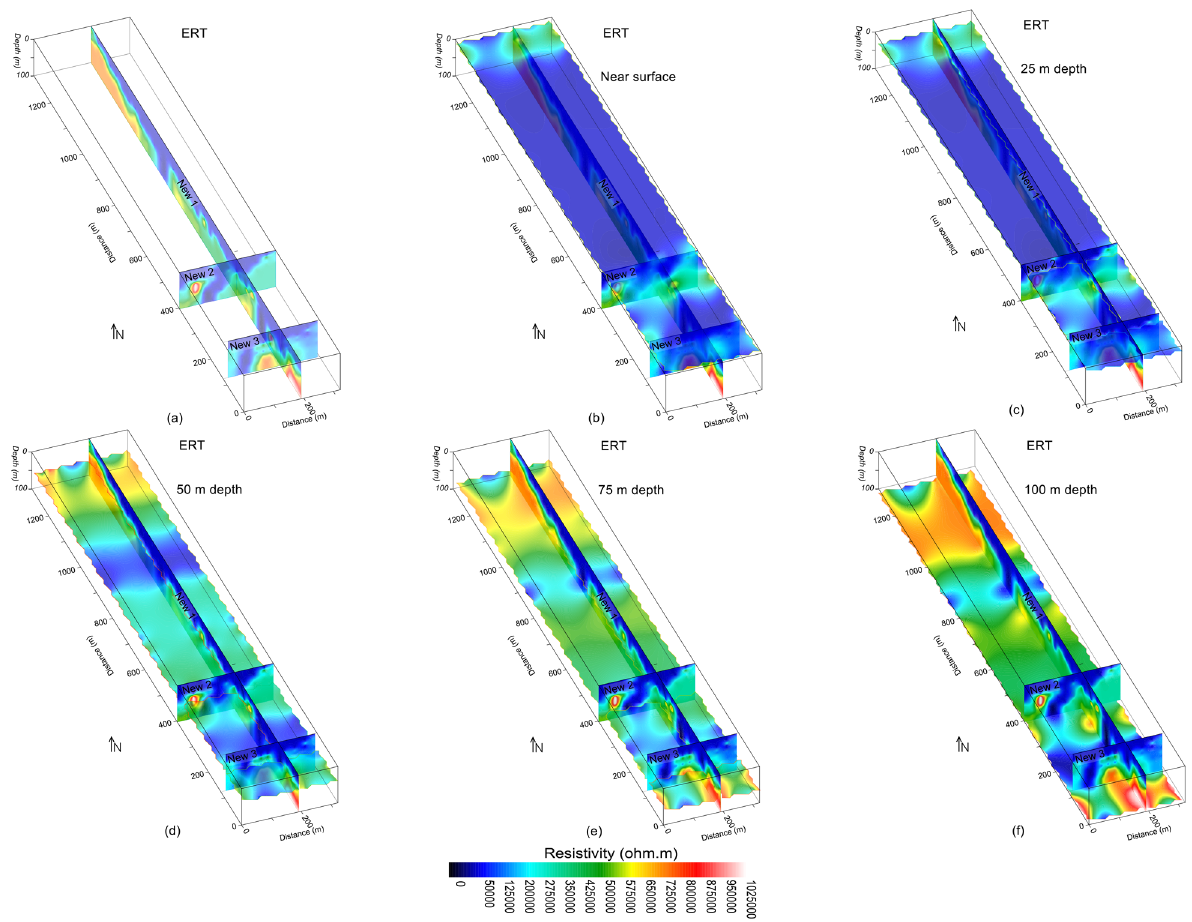
Figure 5. Resistivity imaging (increasing from dark blue to red white on a color scale) for: ( a ) the integration of three ERT profiles; ( b ) ground surface including ( a ); ( c ) 25 m depth including ( a ); ( d ) 50 m depth including ( a ); ( e ) 75 m depth including ( a ); and ( f ) 100 m depth (bottom) including ( a weathered/crushed rock along the ERT profiles are suggested as the most suitable locations for the development of infrastructures. Rock mass quality evaluation using Kv.